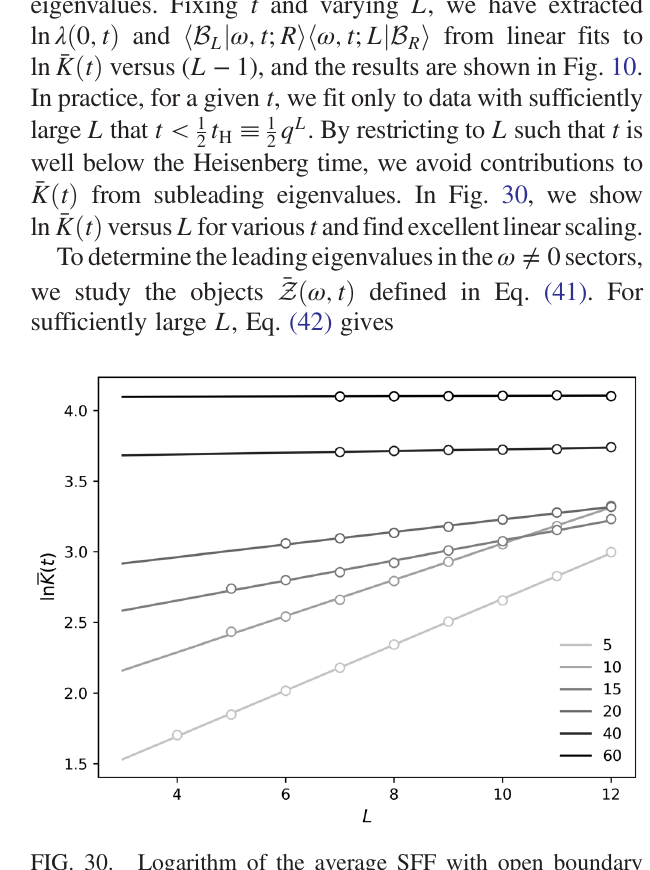
FIG. 29. Distributions of eigenvalues of the average transfer ¯ T ð t Þ matrix for times t ¼ 4 and t ¼ 5 , and for q ¼ 2 , 3, 4, in the complex plane. The black points show eigenvalues in sectors with ω ¼ − ω þ − , and the gray points show eigenvalues in all other sectors. The t leading eigenvalues, some degenerate, are distrib- uted around unity.